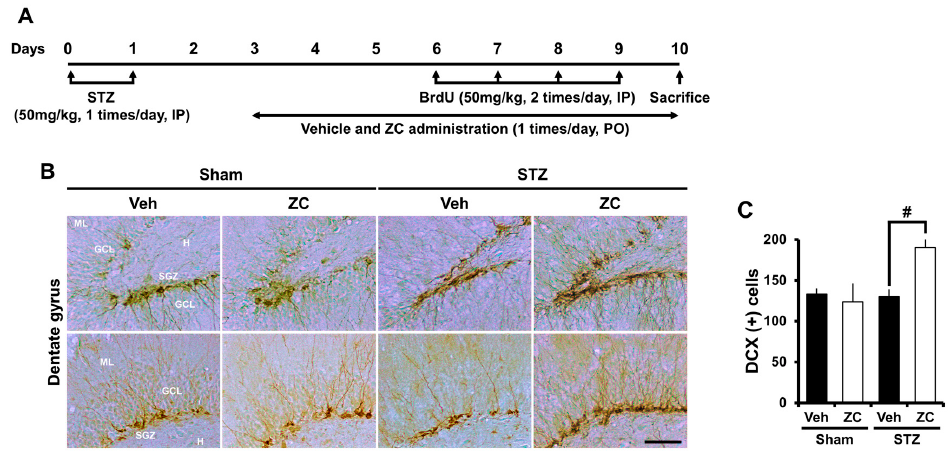
Figure 3. ZC increases DCX-positive cells in the early phase of STZ-induced diabetic rats. ( A ) Experimental procedure in the early phase of STZ-induced diabetic rats; ( B ) Photomicrographs show DCX (+) neuroblasts in the hippocampal DG. The STZ-injected group showed a similar level of DCX expression compared to the sham-operated group. However, ZC treatment by gavage for one week after STZ-induced hyperglycemia significantly increased DCX (+) cells. Scale bar = 100 µm; ( C ) Bar graph represents the number of DCX-positive cells in the SGZ/GCL. Data are means ± SE, n = 7–12 from each group. # p < 0.05, versus vehicle-treated STZ group. ML: molecular layer; GCL: granular cell layer; SGZ: subgranular zone; H: hilus.